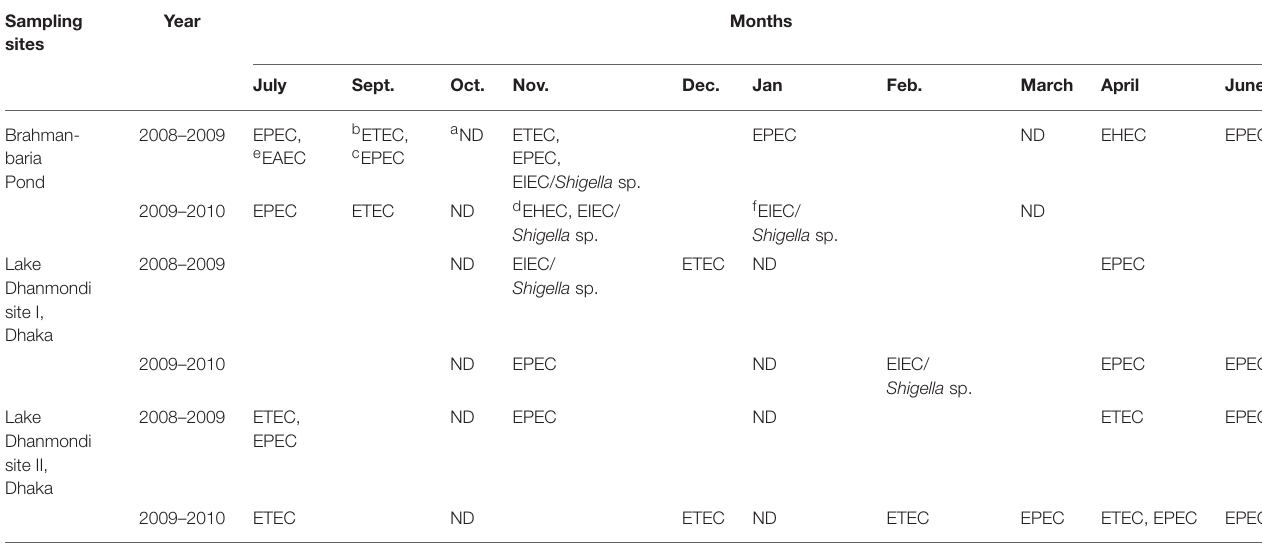
TABLE 4 | Presence of diarrheagenic E. coli pathotypes and Shigella spp. in Brahmanbaria pond and Lake Dhanmondi, Dhaka in July 2008–June 2010. Sampling